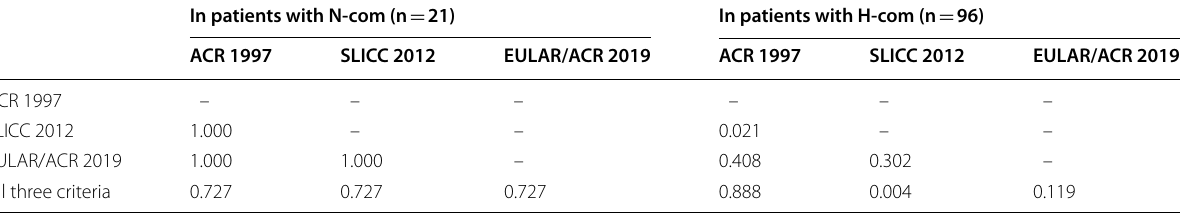
All three SLE Systemic lupus erythematosus; N-com Normal serum levels of C3, C4, and CH50; H-com Less than normal serum levels of one or more complements in C3, C4, and/ or CH50; ACR American College of Rheumatology; SLICC Systemic Lupus International Collaborating Clinics; EULAR European League Against Rheumatism